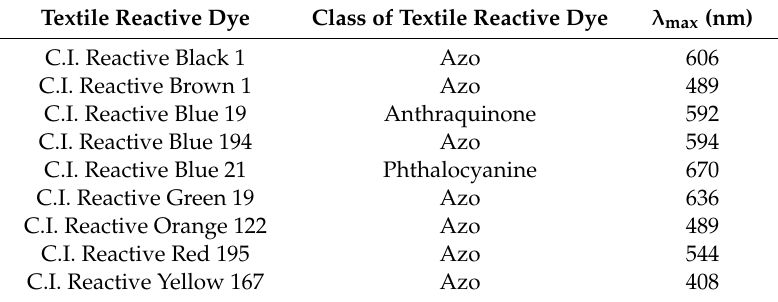
Table 1. Properties of the nine reactive dyes used in this